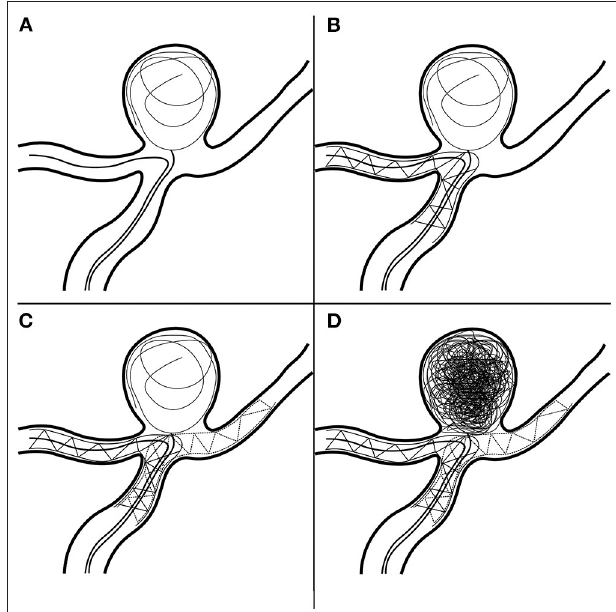
FIGURE 4 | Procedures in the Y-stent-assisted coil embolization. (A) Wove a basket with a coil. (B) Deployment of first stent. (C) Deployment of second stent. (D) Complete occlusion of the aneurysm.